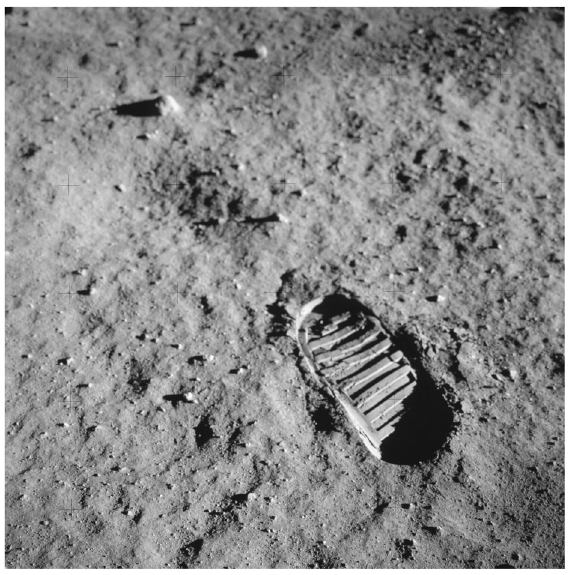
Fig. 1 Footprint in lunar regolith. The footstep of Buzz Aldrin compacting fi ne grains of lunar soil during an Apollo 11 EVA 81 . Copyright © NASA Public Domain .